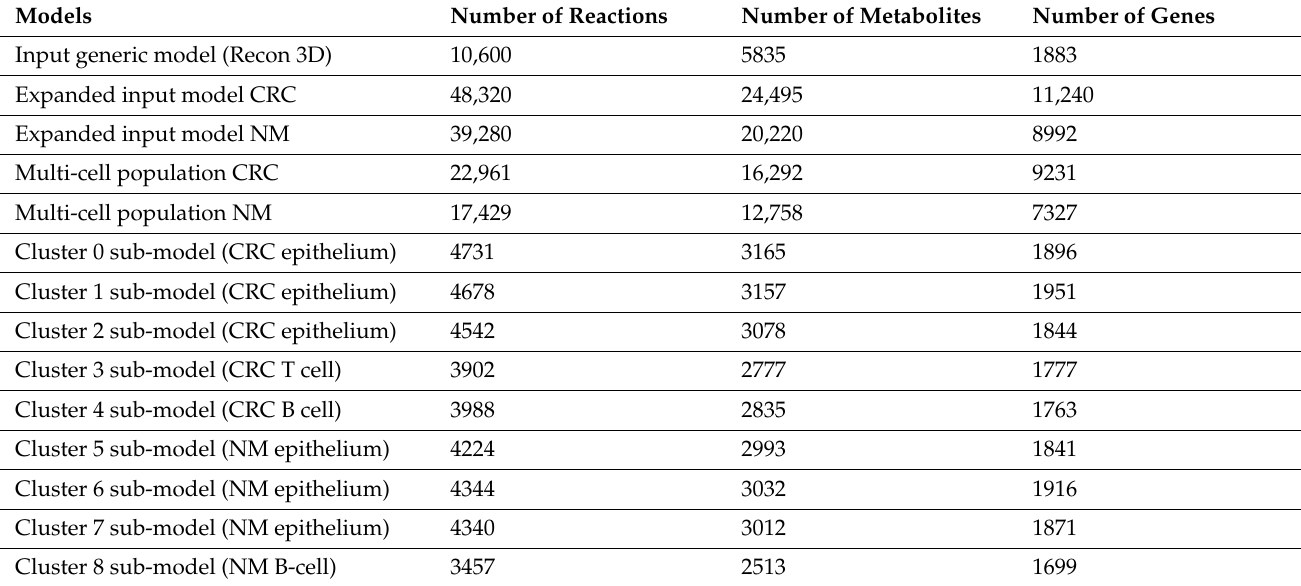
Table 1. Summary of the different models for colorectal cancer (CRC) and normal mucosa (NM) examples (Datasets 1 and 2). The number of reactions, metabolites and genes are given for the input generic model, expanded input models, multi-cell population models and all the sub-models. The multi-cell models include, besides the reactions, metabolites and genes present in all sub-models, transport and exchange reactions and metabolites and their associated